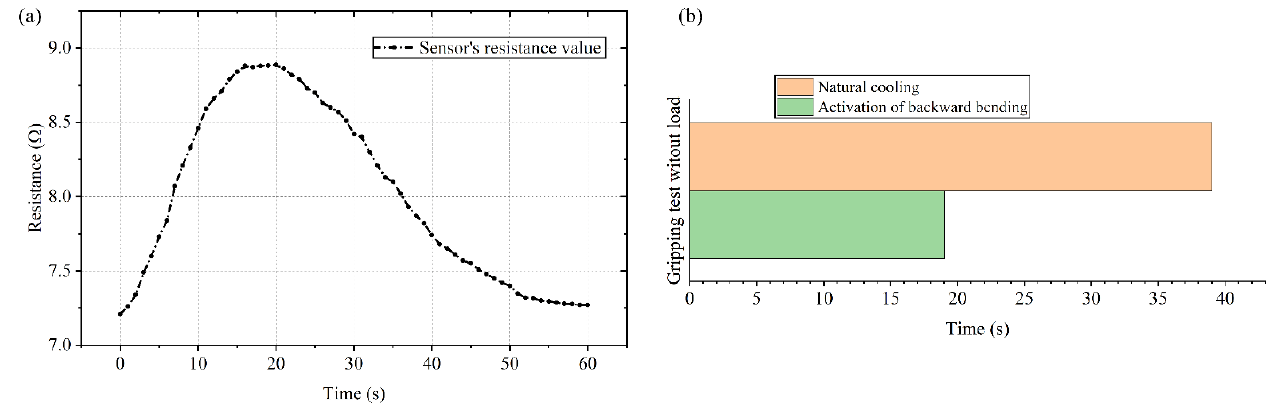
Figure 12. The whole gripping process without a load. Definitions of the four stages with their in- frared thermograms during the grasping process.